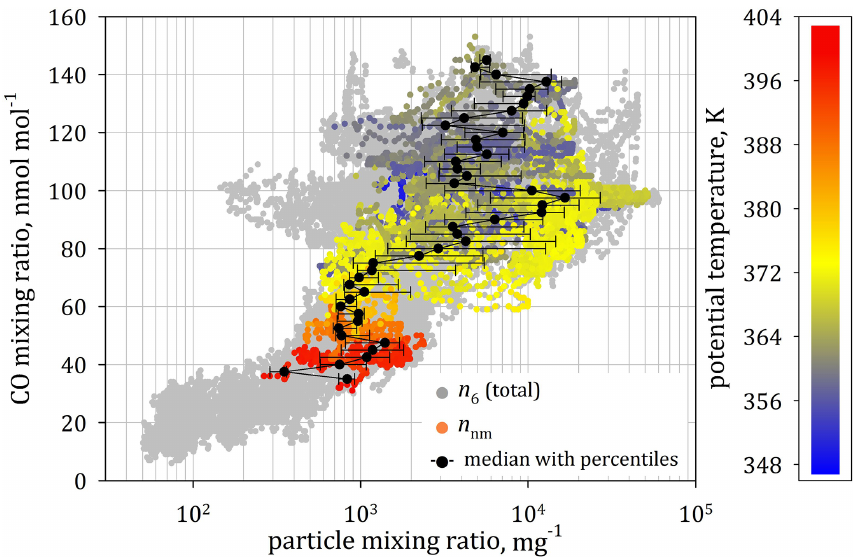
Figure 8. Particle mixing ratio of fine-mode particles n 6 (grey dots in the background) and of nucleation-mode particles n nm (colour-coded with reference to the potential temperature) in relationship to the CO mixing ratio. The median n nm with the 25th and 75th percentile is shown in bin widths of 2.5nmolmol − 1 of the CO mixing ratio (black